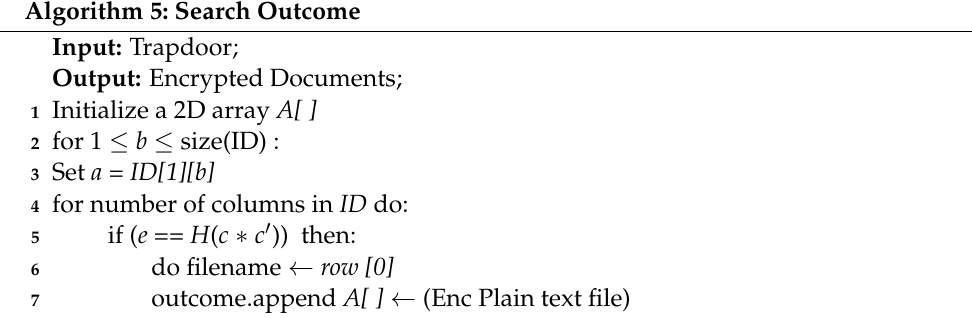
Algorithm 5: Search